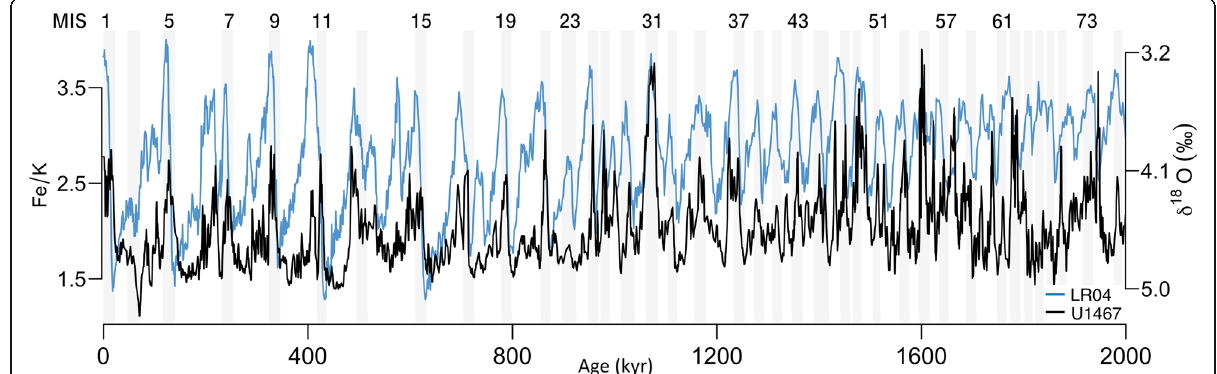
Fig. 12 The Fe/K record and the LR04 benthic stable oxygen isotope stack against age (kyr). A three-point moving average smoothing was applied to the Fe/K